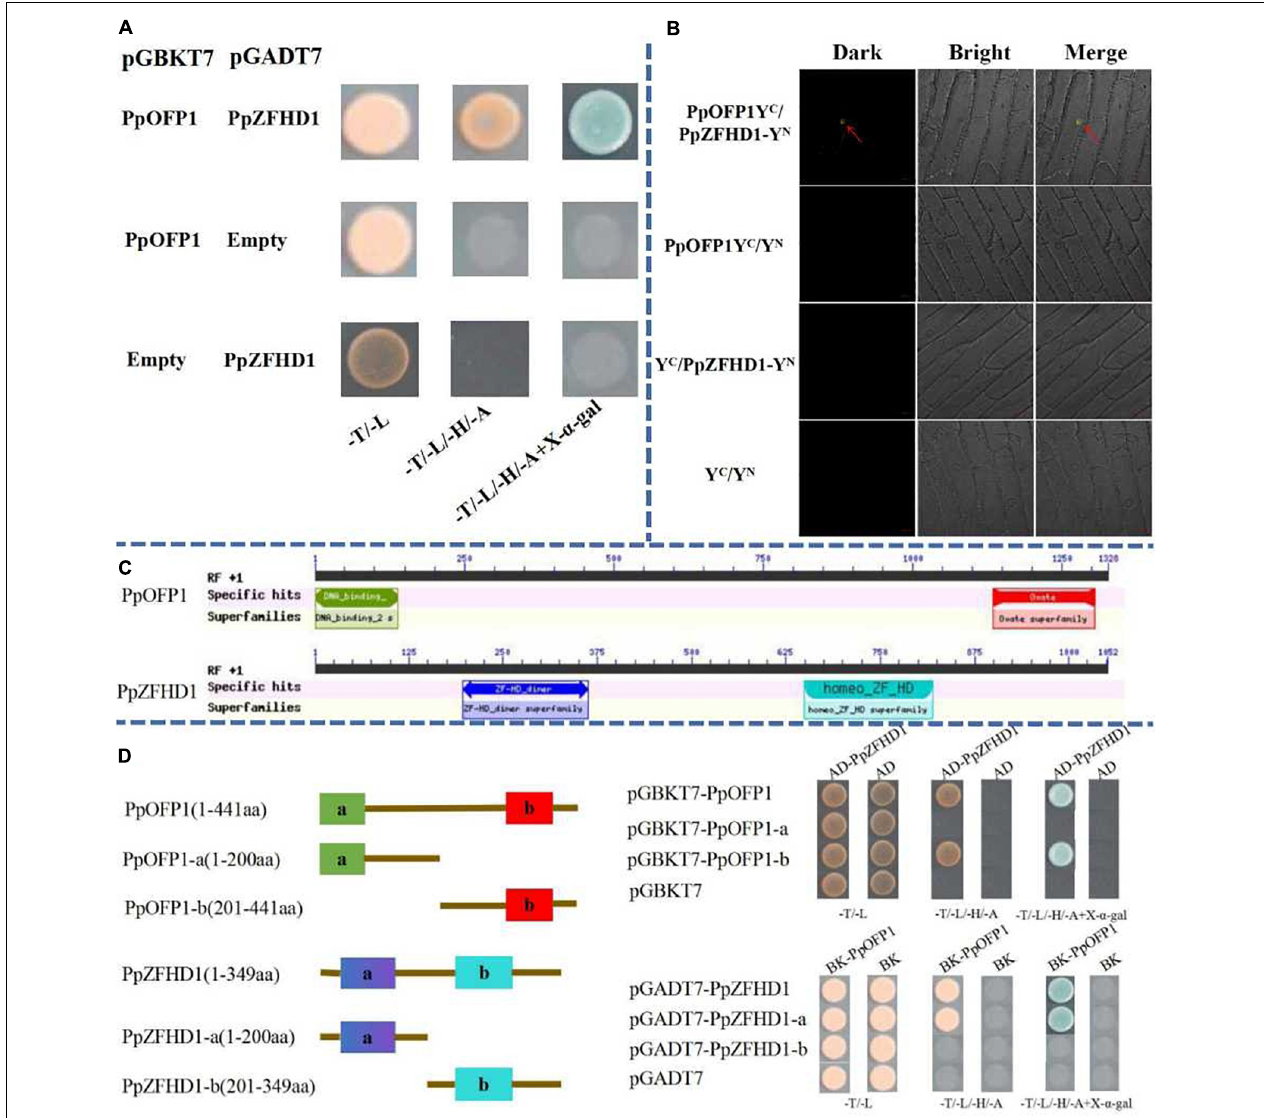
FIGURE 4 | Interaction between PpOFP1 and PpZFHD1 proteins. (A) Interaction between PpOFP1 and PpZFHD1 proteins was verified by yeast double hybridization assay. (B) Interaction between PpOFP1 and PpZFHD1 proteins was verified by BiFC. Red arrows indicate where a green fluorescence signal was detected in the nucleus. (C) Conserved domains in PpOFP1 and PpZFHD1 proteins were predicted by the NCBI CDD online tool (https://www.ncbi.nlm.nih.gov/Structure/cdd/wrpsb.cgi). PpOFP1 has two conserved domains: the N-terminal DNA-binding domain (PF13724) and the C-terminal OVATE domain (PF04844). There are also two domains in PpZFHD1 , the ZF-HD_dimer domain (PF04770) at the N-terminal and the homeo_ZF_HD domain (TIGR01565) at the C-terminal. (D) Identification of the interaction region between PpOFP1 and PpZFHD1 . a and b of PpOFP1 protein in (D) indicate the N-terminal DNA-binding domain (PF13724) and the C-terminal OVATE domain (PF04844), respectively. a and b of PpZFHD1 protein in (D) indicate the ZF-HD_dimer domain (PF04770) at the N-terminal and the homeo_ZF_HD domain (TIGR01565) at the C-terminal,